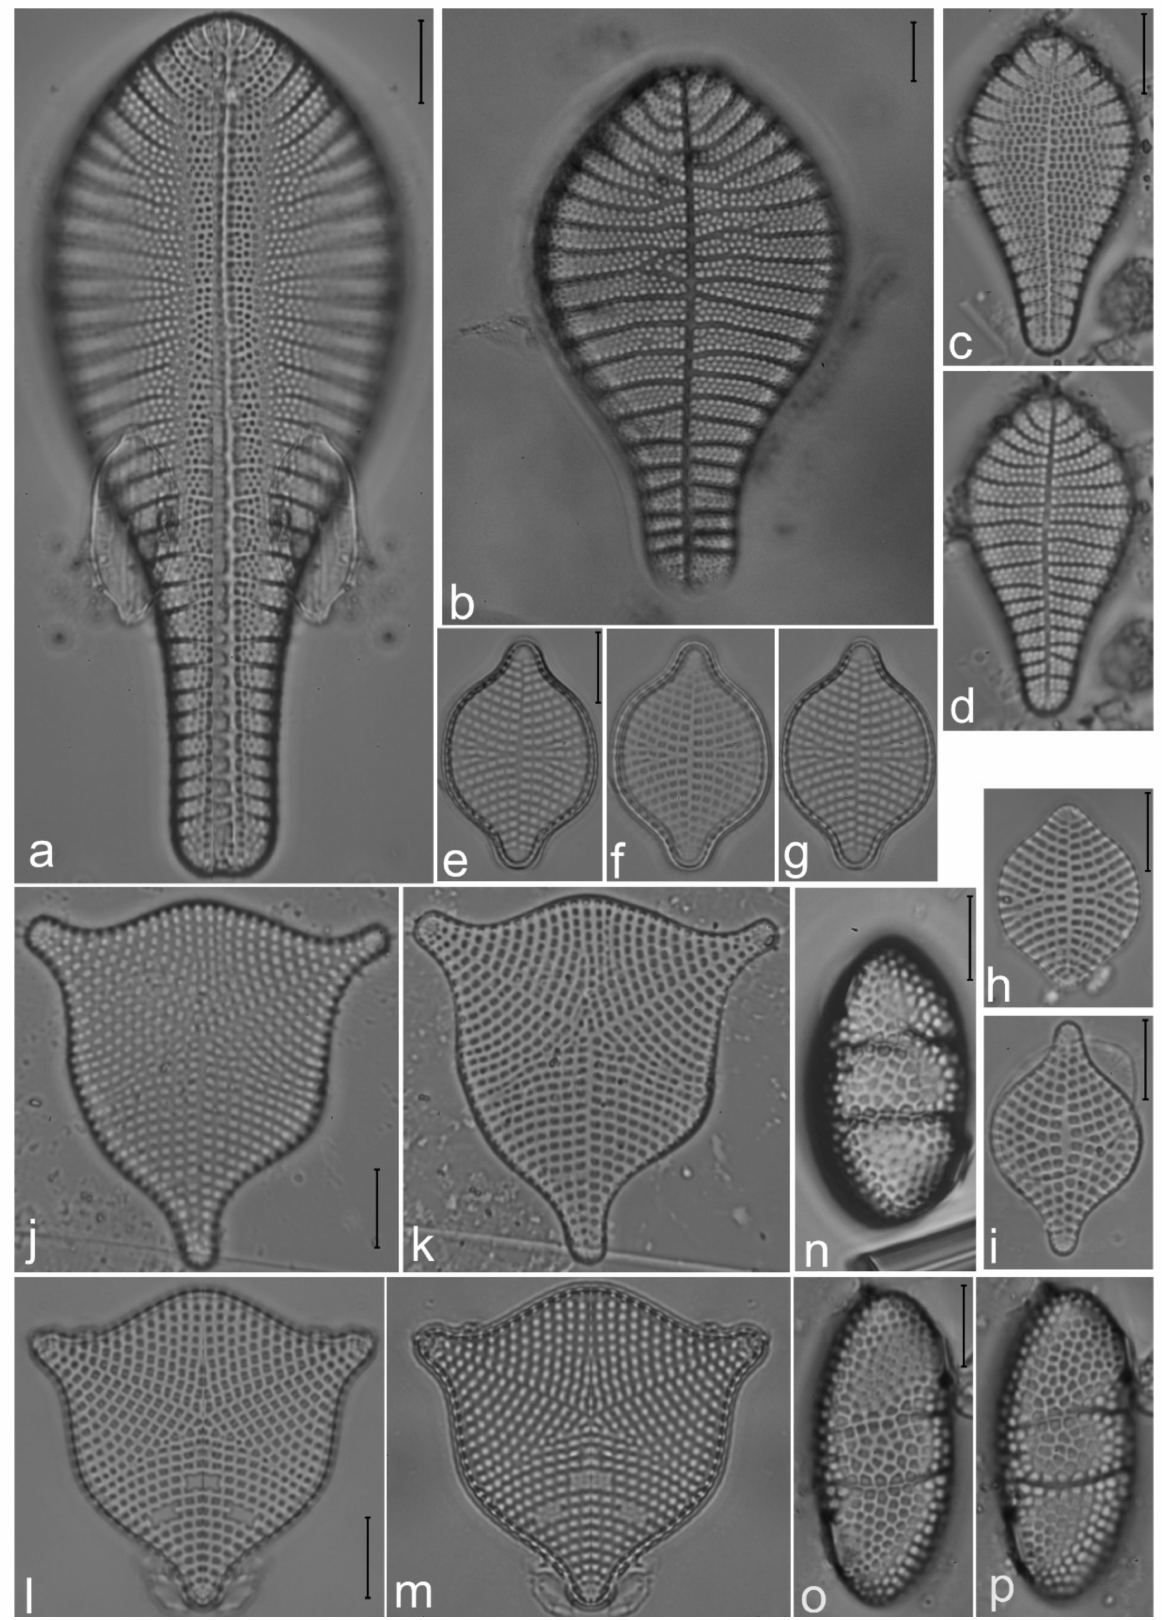
Figure 8. ( a – d ) Podocystis adriatica showing range in size; ( e – i ) Rhaphoneis amphiceros var. amphiceros ; ( j – m ) R. amphiceros var. elegans ; ( n – p ) Neohuttonia reichardtii . Scale bar = 10 µ